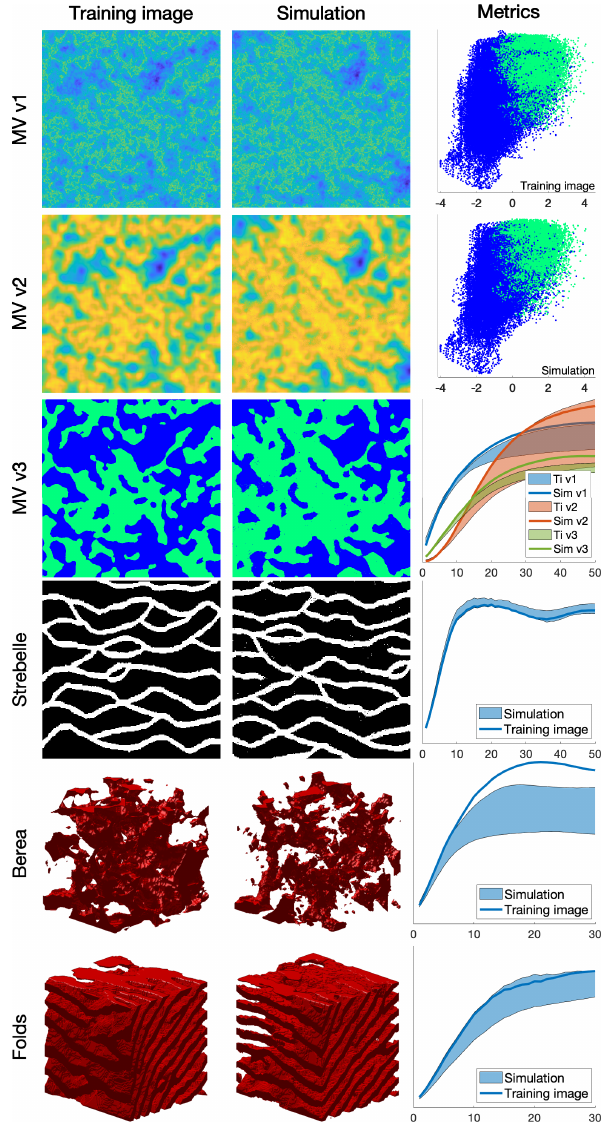
Figure 3. Examples of unconditional continuous and categorical simulations in 2D and 3D and their variograms. The first column shows the training images that were used, the second column one re- alization, and the third column quantitative quality metrics. MV v1, MV v2, and MV v3 represent a multivariate training image (and the corresponding simulation) using three variables. The first two met- rics are scatter plots of MV v1 vs. MV v2 of the training image and the simulation, respectively. The third metric represents the repro- duction of the variogram for each of MV v1, MV v2, and MV